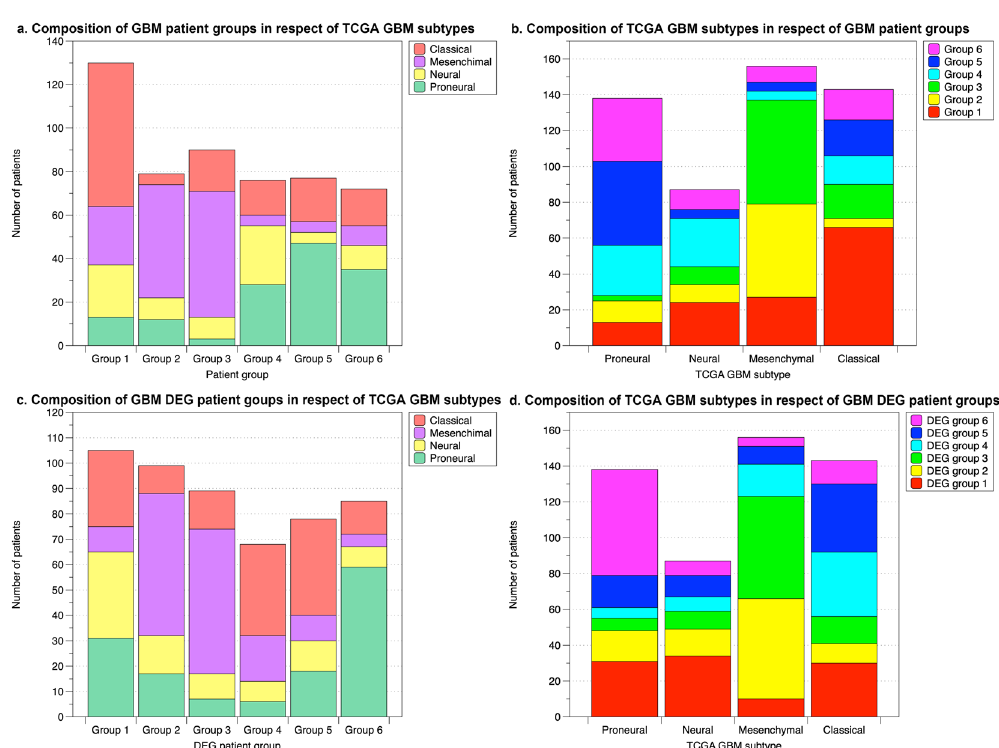
Figure 6. The comparison between GBM patient groups and DEG patient groups with the TCGA GBM subtypes. ( a , c ) show the composition of patient groups/DEG patient groups in respect of TCGA GBM subtypes. ( b , d ) show the composition of TCGA GBM subtypes in respect of patient/DEG patient